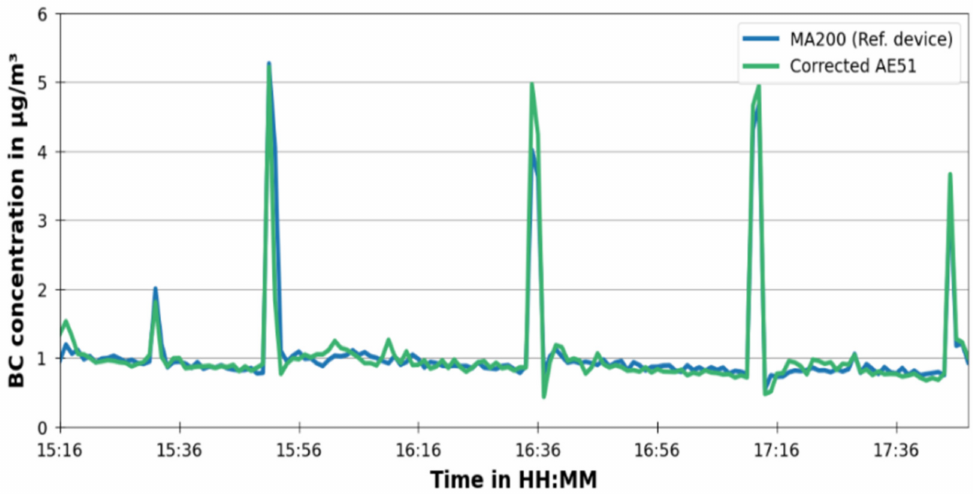
Figure 16. Comparison between the reference device data (MA200) and the corrected data (AE51).